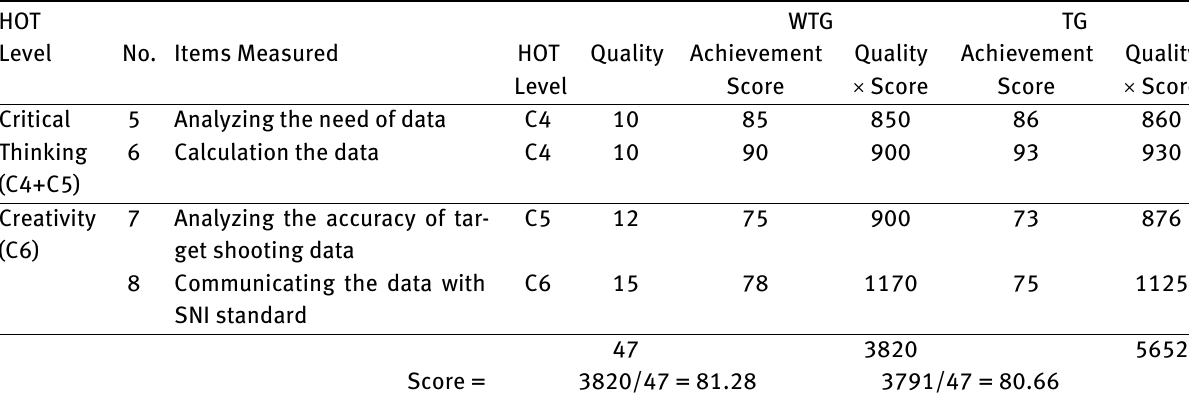
Table 3: Cognitive evaluation result to get HOTS in the second stage HOT WTG TG Level No. Items Measured HOT